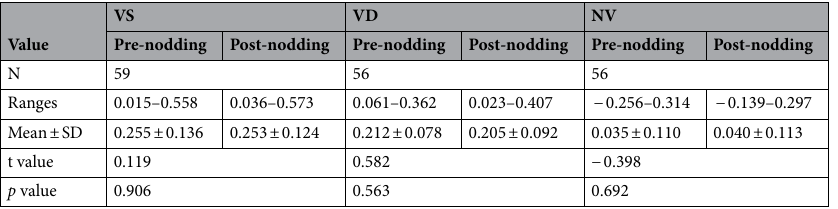
Table 4. Comparison of the volumetric parameters acquired before and after the head-nodding period. Volumetric values are given in microliters. The positive value above means flowing caudal direction. The outliers were removed via Box and Whisker Plots